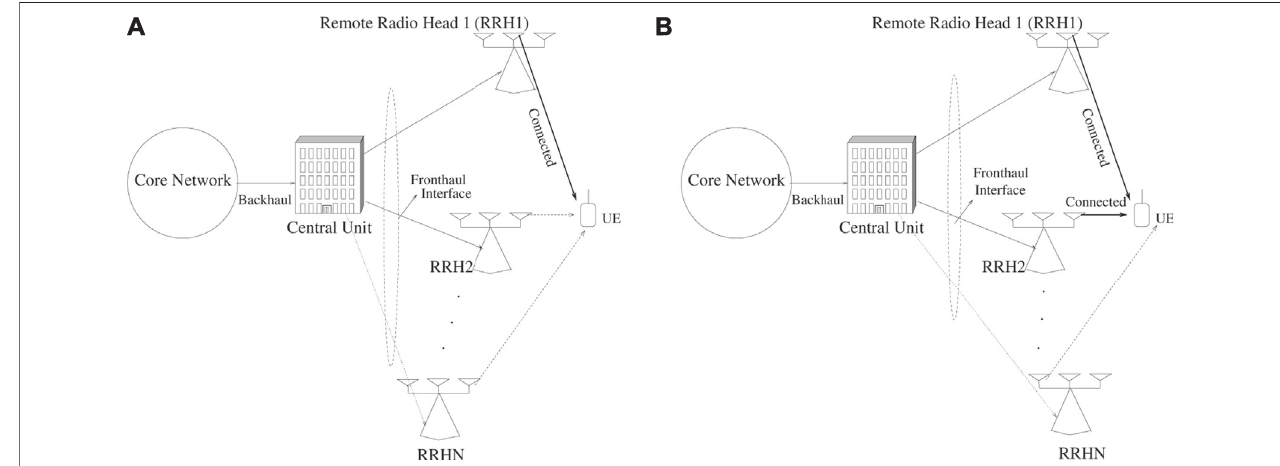
FIGURE 3 | (A) RRH1 connected to the user equipment to communicate via beamforming. (B) Two RRHs connected to the user equipment using beamforming combined with STBC or SM.